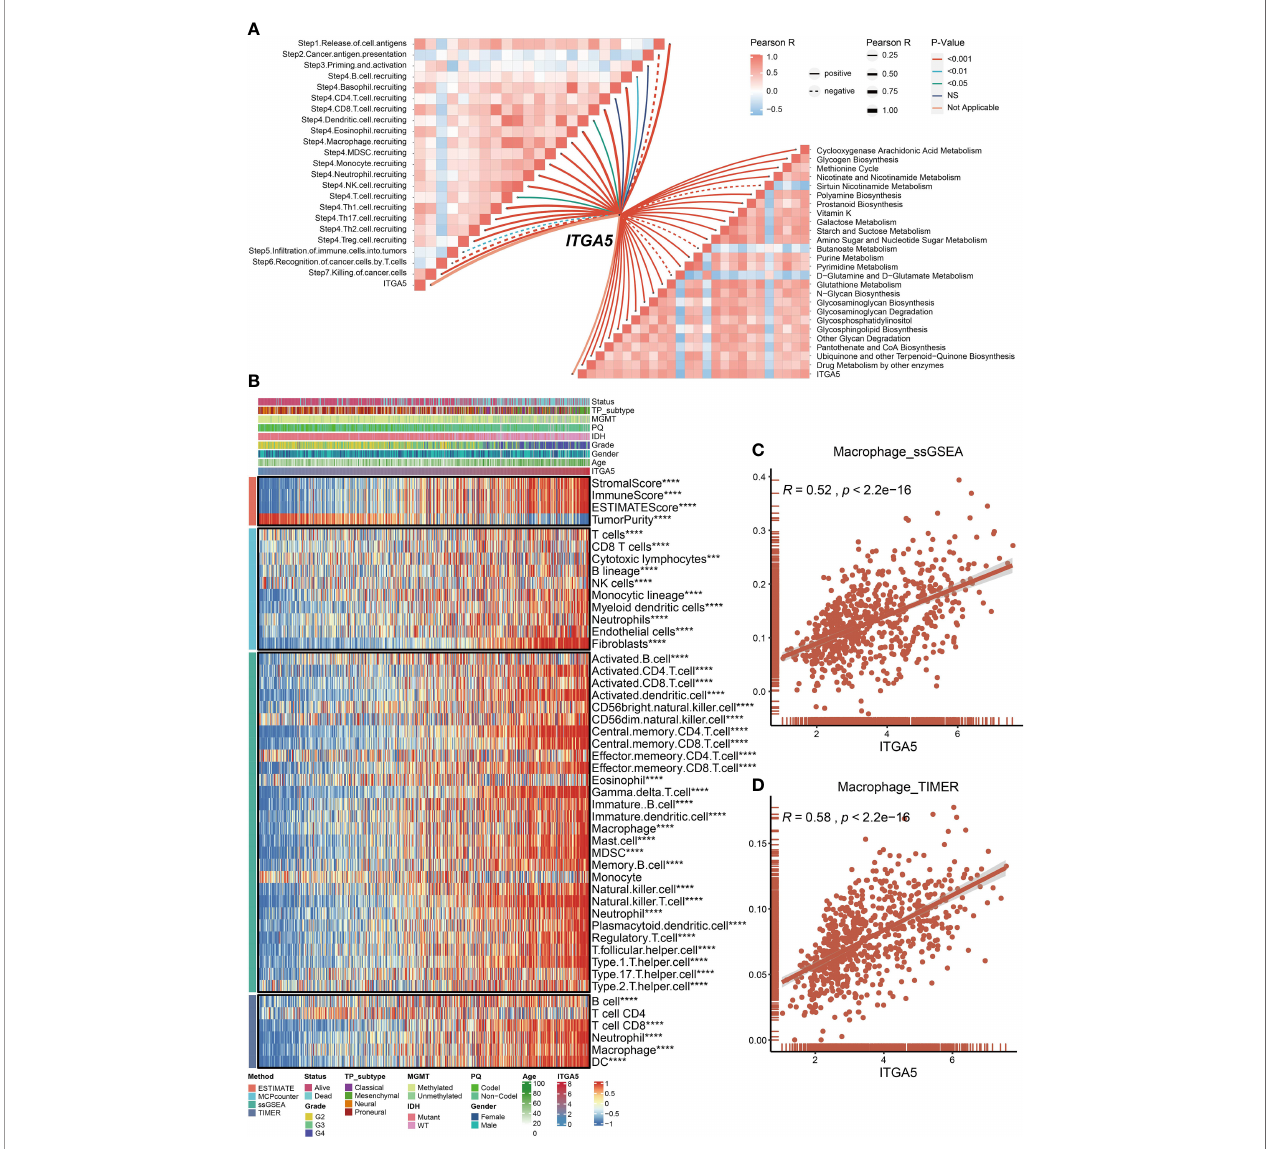
FIGURE 5 | Roles of ITGA5 in immune and metabolism phenotypes in the TCGA cohort. (A) Correlations between ITGA5 and enrichment scores of metabolism- relevant pathways together with the steps of the cancer immune cascades. (B) Heatmap visualized the abundance of in fi ltrating immune cell populations with different ITGA5 levels, based on the ESTIMATE, the MCPcounter, the ssGSEA, and the TIMER algorithms. *P < 0.05, **P < 0.01, ***P < 0.001, ****P < 0.0001. (C) The corrplot of the correlation between ITGA5 expression and macrophage cell level of the ssGSEA. (D) The corrplot of the correlation between ITGA5 expression and macrophage cell level of the